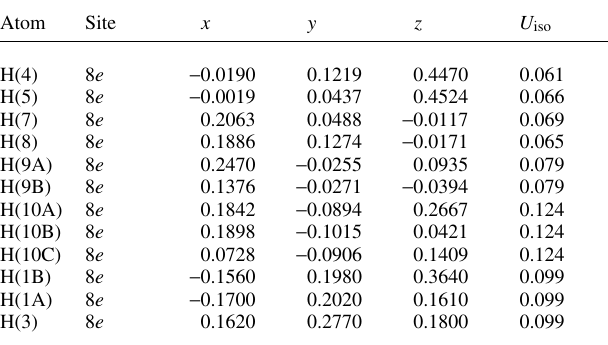
Table 2. Atomic coordinates and displacement parameters (in Å 2 )